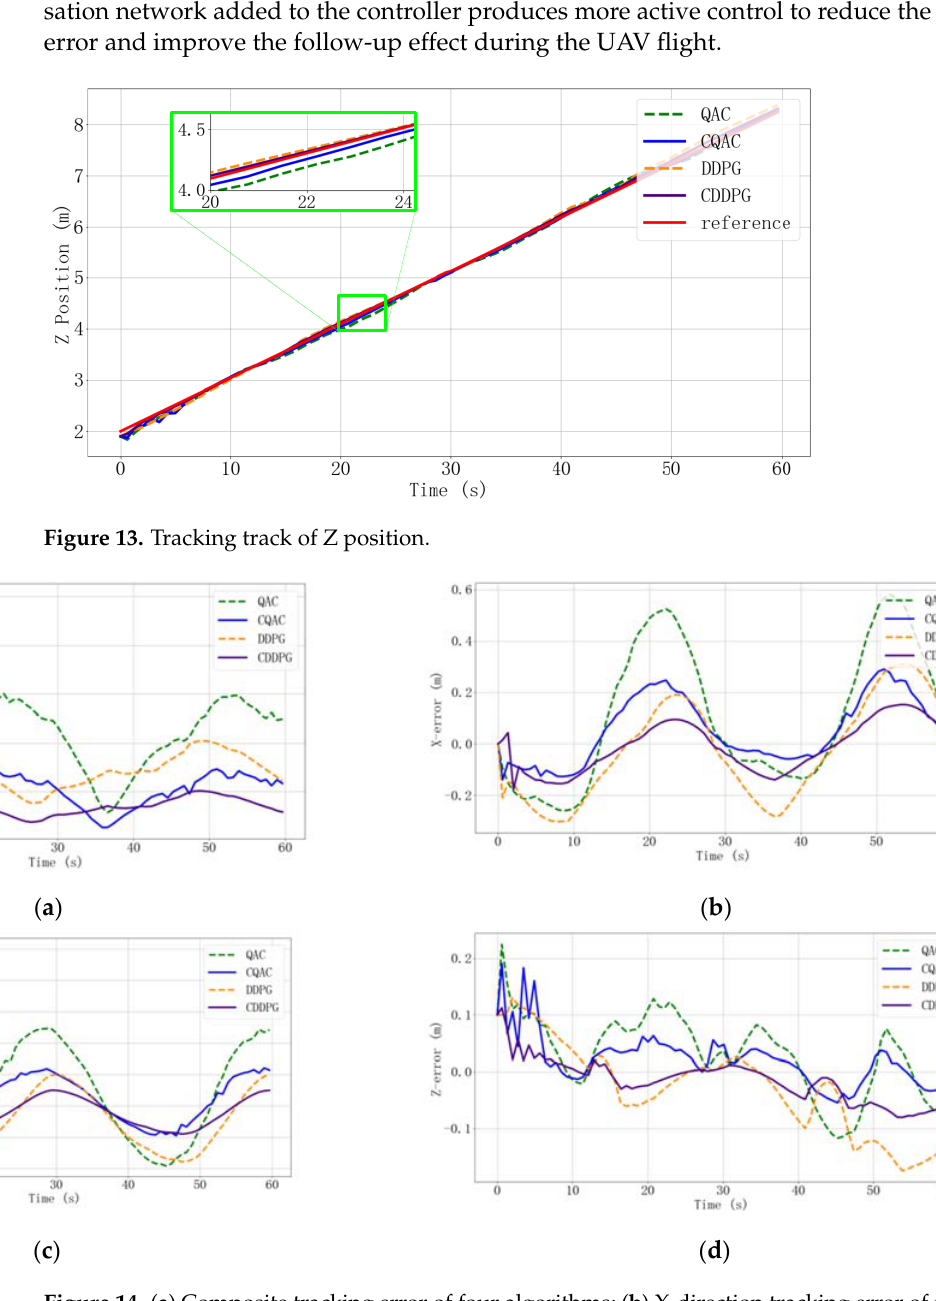
Figure 13. Tracking track of Z position.